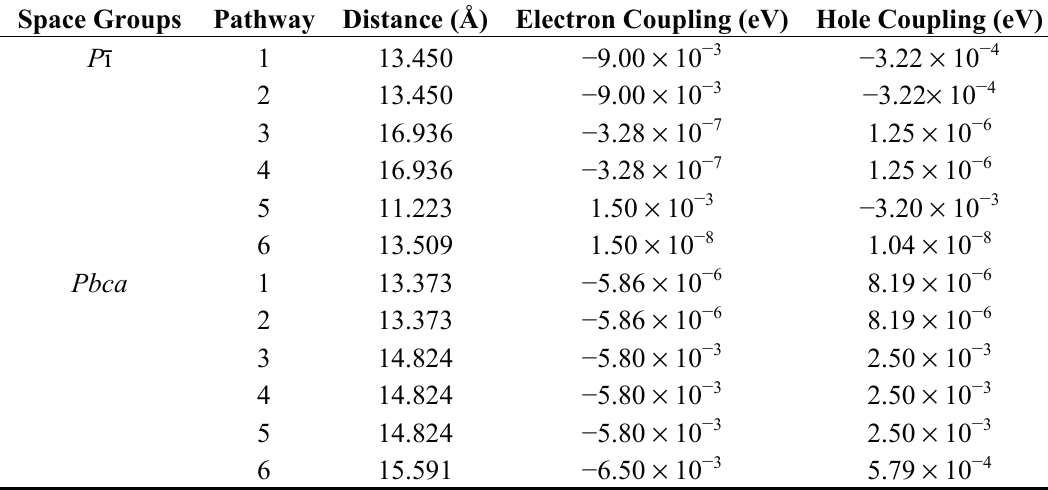
Figure 4. Crystal structures and hopping routes of 1c in different space groups. Table 4. The center-center distance and the corresponding hole and electron coupling between the dimer in all of the nearest neighbor pathways for 1c in different space